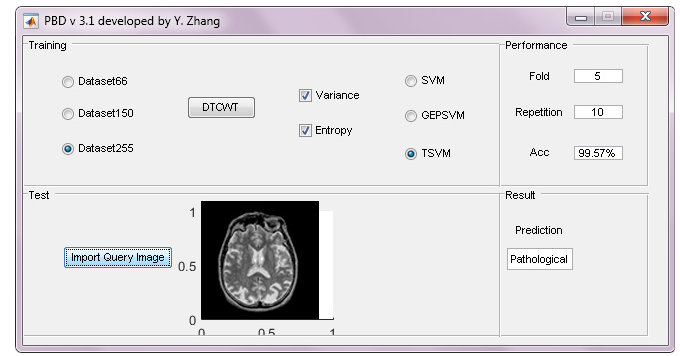
Figure 7. Graphical user interface (GUI) of our developed programs.